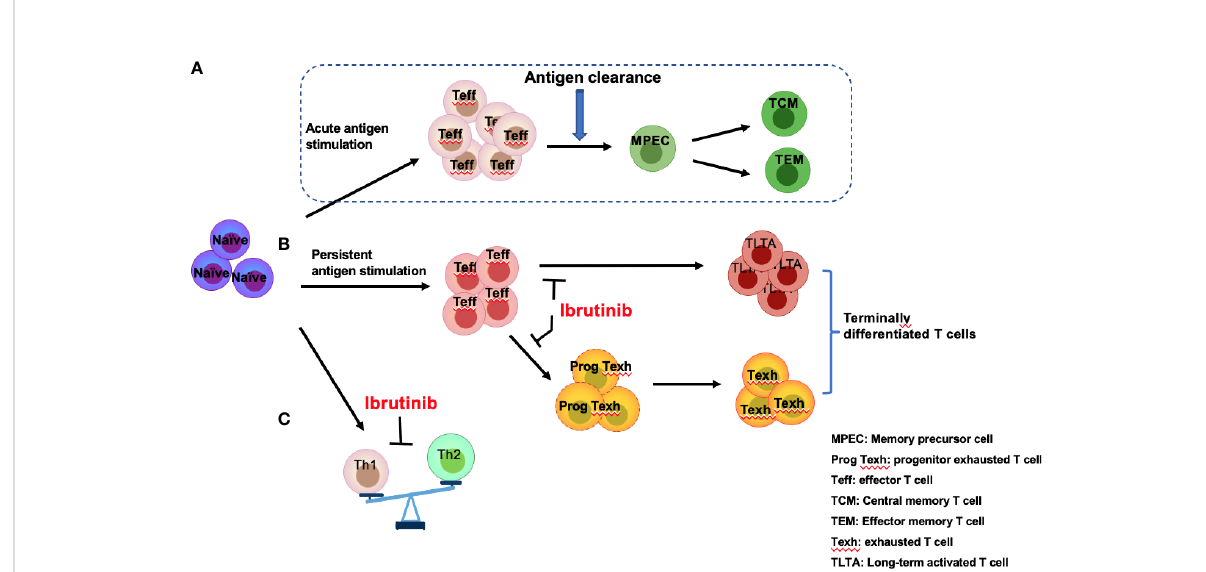
FIGURE 3 Effects of ibrutinib on effector T-cell subgroups. Antigen stimulation drives naïve T cells to differentiate into effector T cells (Teff) followed by rapid expansion of effector T cells, which eventually produce memory precursor cells (MPECs) after antigen clearance, further differentiating into central memory T cells (TCM) and effector memory T cells (TEM) (A) . However, persistent antigen stimulation from infections or CLL-related antigens induces over-activation of T cells and promotes progenitor exhausted T (Prog Texh) cells to differentiate into exhausted T (Texh) cells, which leads to the accumulation of terminally differentiated T cells, including TLTA and Texh cells (B) . In addition, Th1 and Th2 differentiation is unbalanced (C) . Ibrutinib reverses the pseudo-exhaustion of T cells and promotes the activity of effector T cells and the predominant differentiation of Th1 cells in CLL